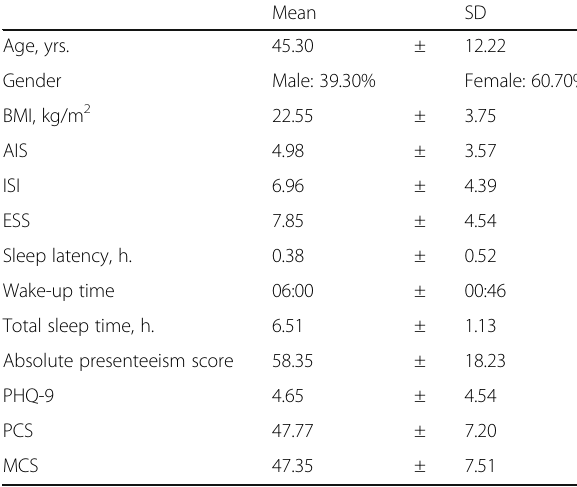
Table 1 and Additional file 1: Figure S1 summarize the participant